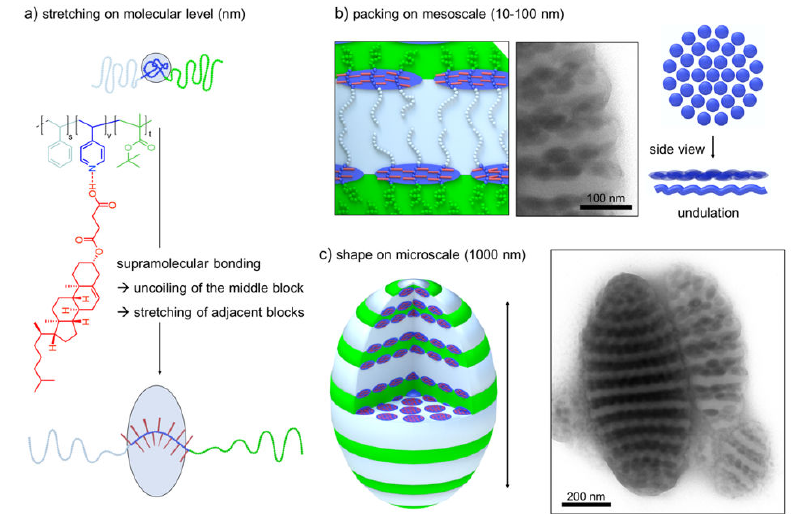
Figure 4. Effect of supramolecular bonding on several length scales. ( a ) Binding of CHEMS causes uncoiling of P4VP and chain stretching of PS and PT. ( b ) On the mesoscale, the stretching results in flattened, lenticular P4VP domains. ( c ) Reorganization of the chains induces axially stacked PS/PT lamellae with shape change of the microparticle to prolate ellipsoids (color code in TEM image: PS grey, P4VP dark grey due to iodine